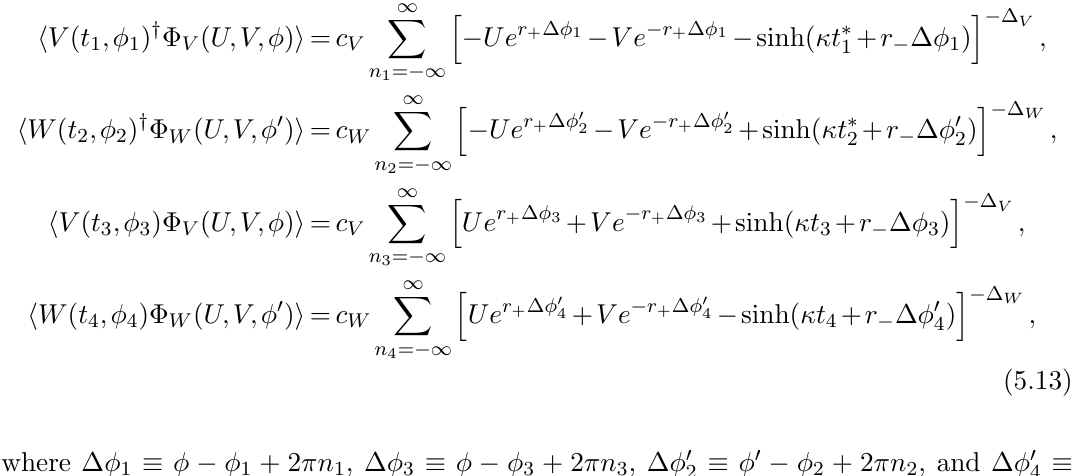
are evaluated on the inner horizon UV = 0, so their simpli(cid:12)ed form